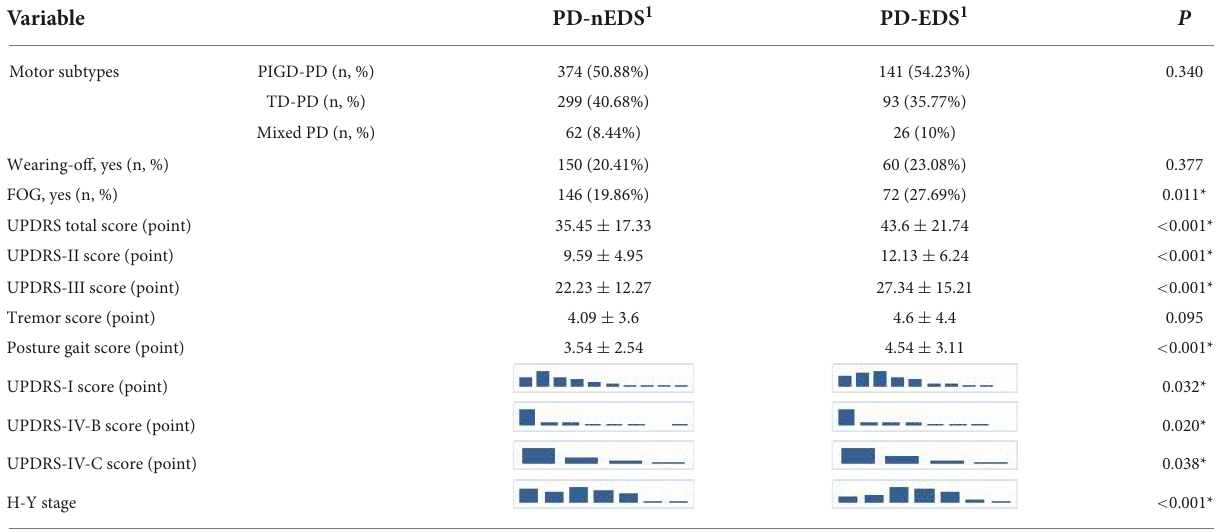
TABLE 2 Comparison of motor symptoms between the PD-EDS 1 and PD-nEDS 1